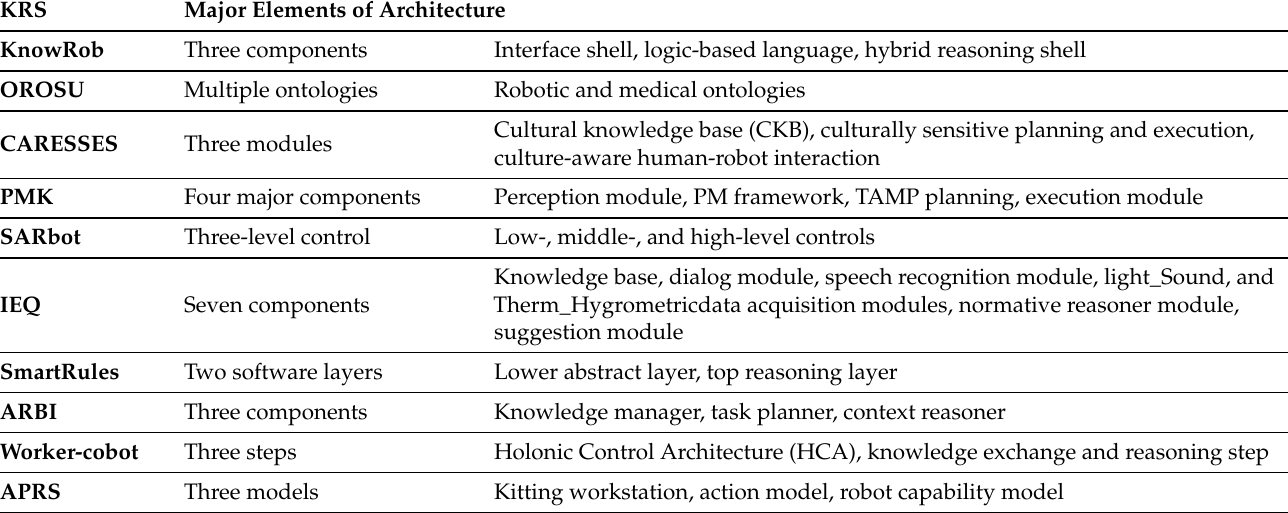
Table 6. KRSs: architectural